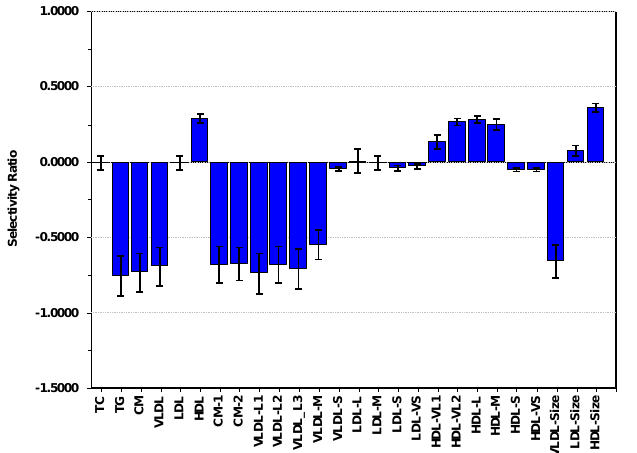
Figure 5. Selectivity ratio plot of a regression model with physical activity as outcome (R2Y = 0.023) and the lipoproteins, adjusted for age, sex, and adiposity, as explanatory variables.